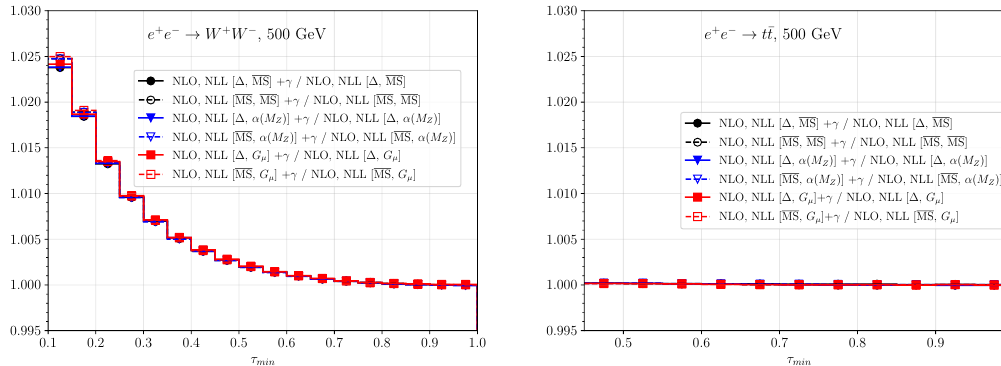
Figure 9 . Ratios of cross sections computed by including photon-initiated partonic contributions over their counterparts computed by discarding such contributions, for all possible combinations of renormalisation and factorisation schemes. Left panel: W + W − production; right panel: t ¯ t production in the full